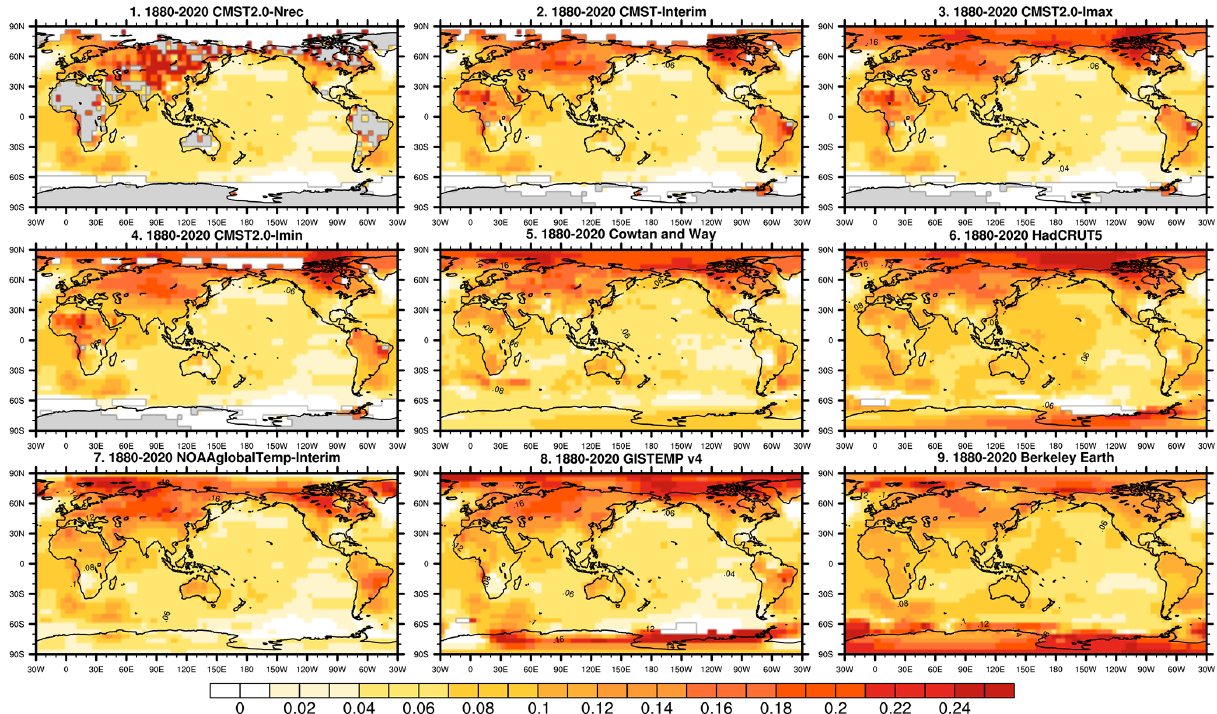
Figure 11. Distribution of warming trends estimated from different datasets during 1880–2020.